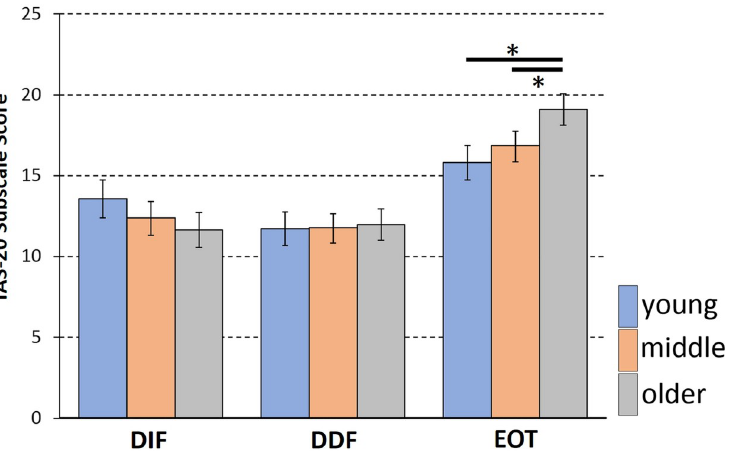
Fig 1. Aging and emotional awareness. Mean subscale scores for the three age groups, with error bars indicating the 95% confidence limits. A significant age group by subscale interaction ( η 2 = .03) was found whereby a significant Age group effect was only confirmed for the EOT subscale (right side of graph). Marked by asterisks ( � ) are the significant post-hoc pairwise comparisons for the EOT score. The older age group differed significantly from the two other groups, indicating an increase in externally oriented thinking, that is, a decrease in emotional awareness with advancing age.